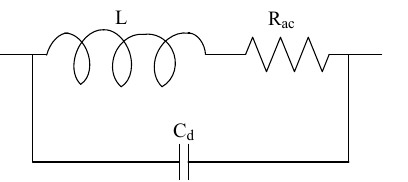
Figure 4. Simplified non-ideal micro coil electrical model (Grandi et al., 1996; Naishadham, 2011).